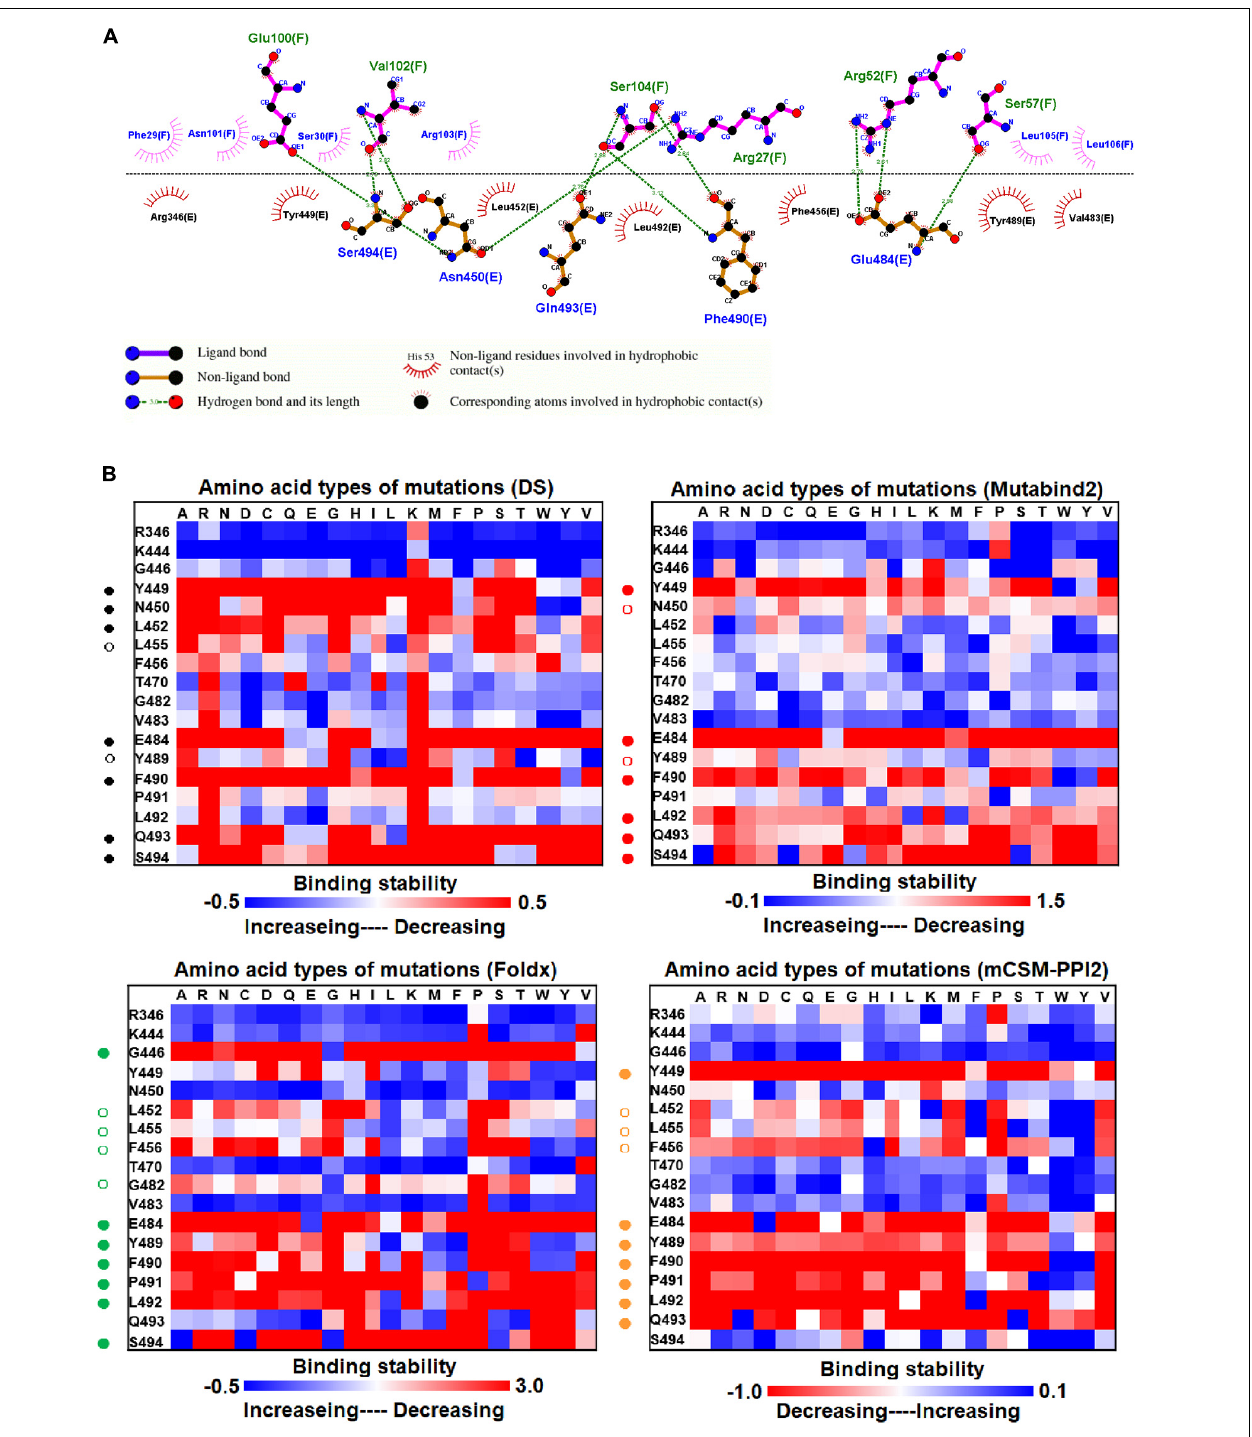
FIGURE 2 | The mutational binding stabilities of RBD variants interacting to H11-D4 nanobody. (A) The molecular interactions of SARS-CoV-2 RBD with H11-D4 nanobody analyzed by ligplot. The chains E and F correspond to RBD and H11-D4 nanobody, respectively. (B) The heatmap of interactive residues of RBD derived from the calculated mutational binding stabilities by using Discovery Studio 3.5 (DS), Mutabind2, FoldX, and mCSM-PPI2. The boxes of each mutations were colored with the gradient of a range between blue (stabilized binding) and red (destabilized binding). In all panels, the solid and hollow circles denote significant and moderate decreases of the binding stabilities,